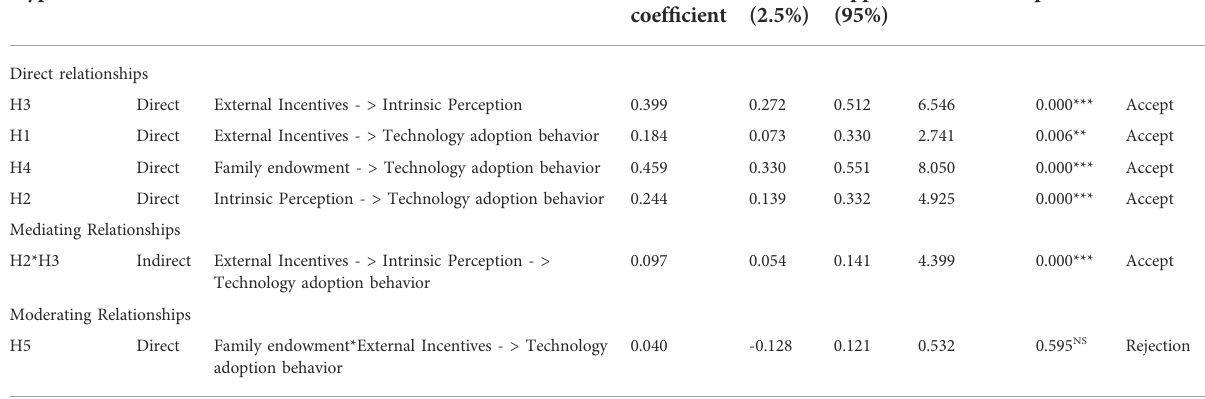
TABLE 3 Results of hypothesis testing. Hypothesis Effect